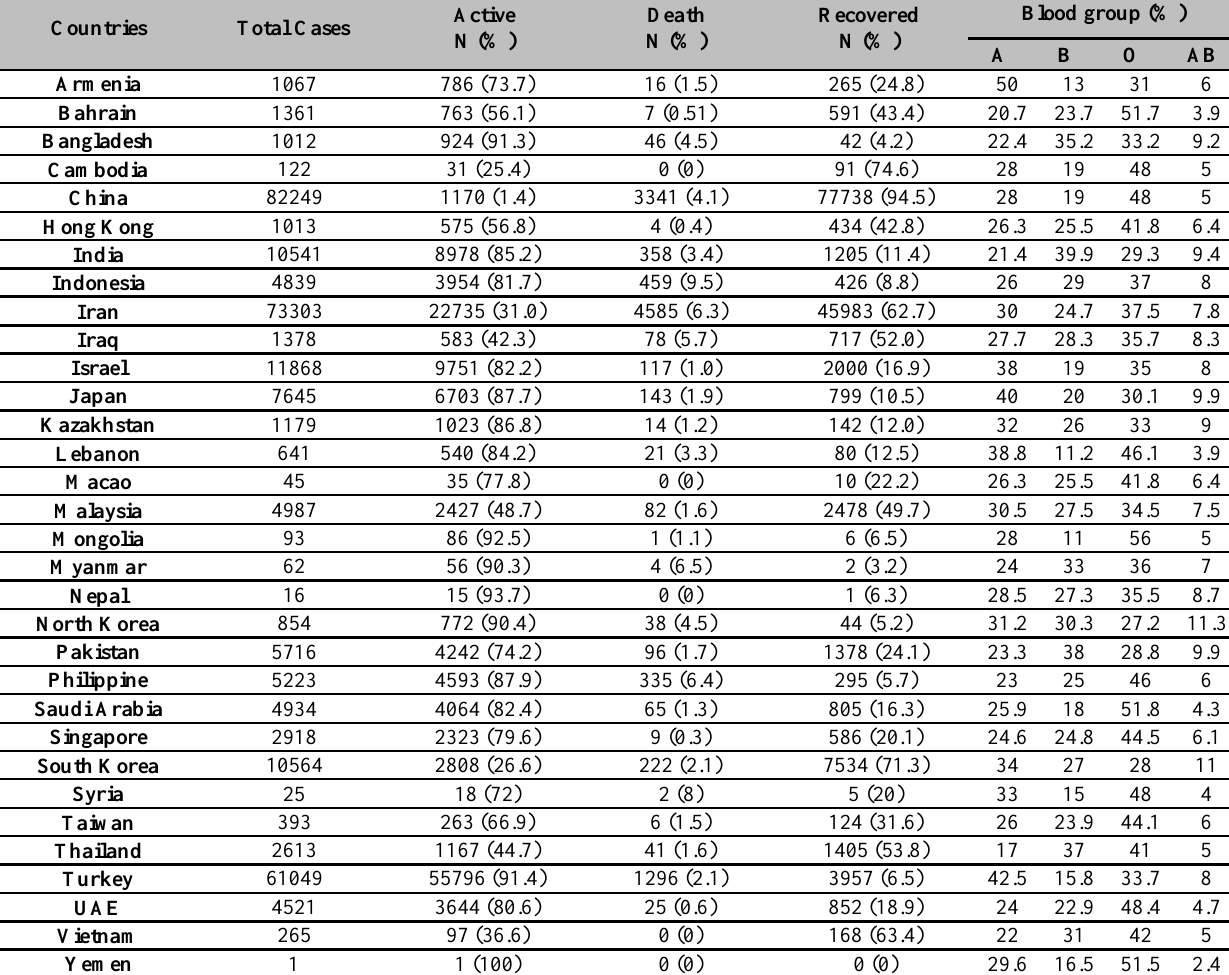
Table 1. COVID-19 in 32 Asian Countries on the 13 th of April 2020 and the distribution of ABO blood group in these countries Countries